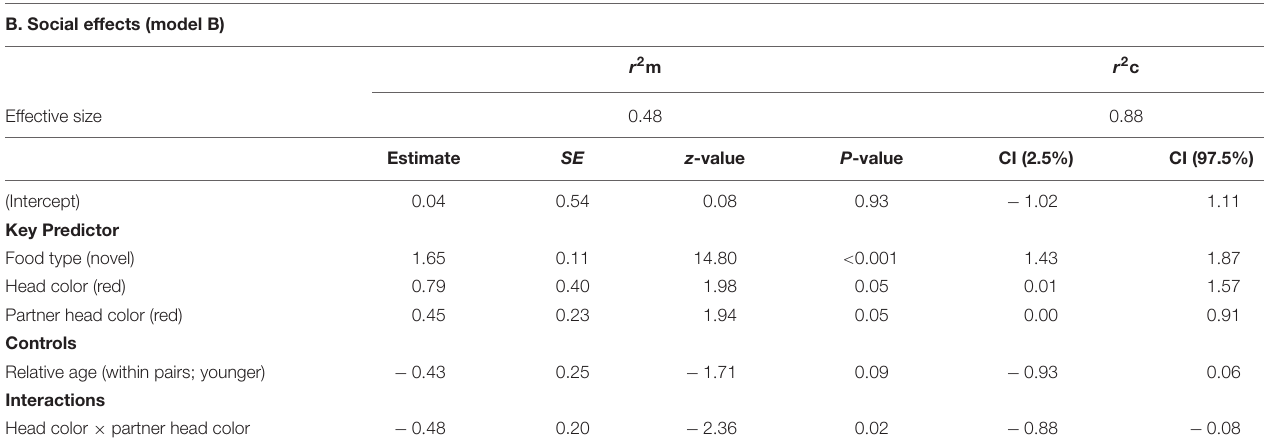
Table 3 . For model A, testing for effects of head color and seed type ( Table 3A ), there were no significant interactions. There were significant main effects of food type (LRT = 57.09, df = 1, P = 0.001) and age (LRT = 5.25, df = 1, P = 0.022). Birds were faster to feed on familiar food (mean = 356 s ± 542 s) than on novel food (mean = 7202 s ± 10698 s). One- year old birds were faster to first feed, irrespective of food type (mean = 1272 ± 2949 s) than were older birds (mean = 4973 ± 9659 s). Table 3B . There were no significant interactions and no